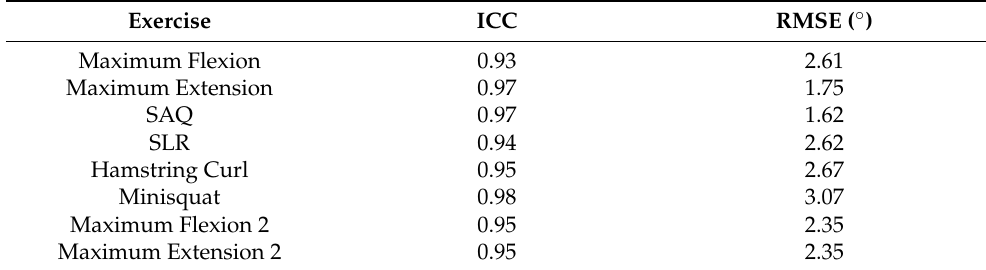
Table 2. Inter-rater reliability between the Knee Brace and OptiTrack Systems for each exercise for ROM measurements.